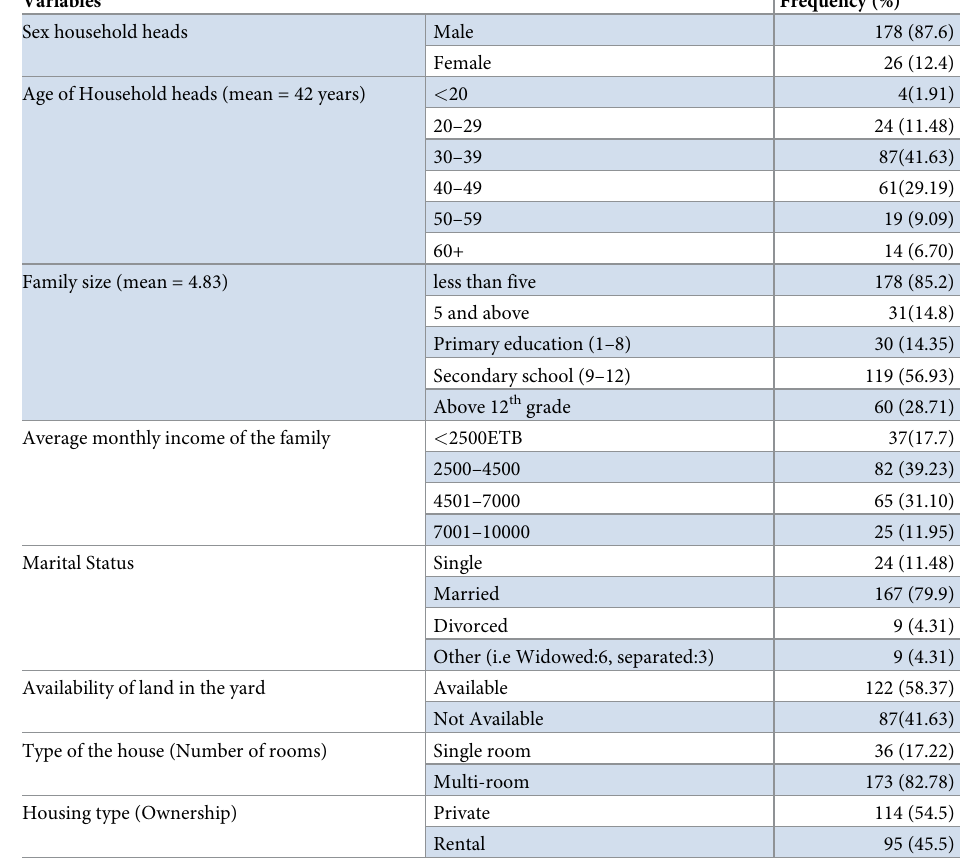
Table 1. Socio-demographic characteristics of respondents in Bedelle town, Southwest Ethiopia, 2021.